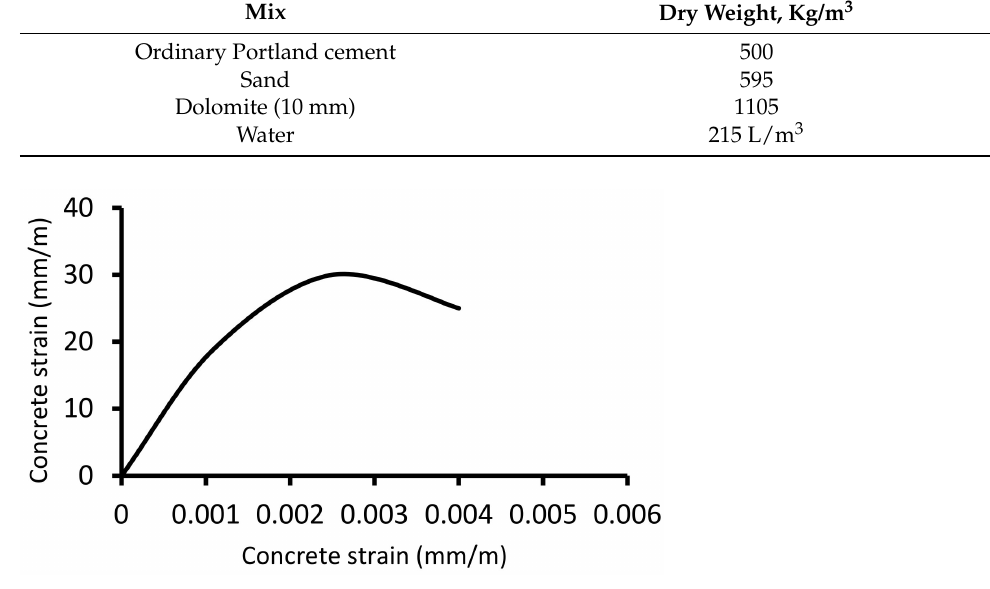
Figure 8. Average stress–strain curves for concrete mixes of